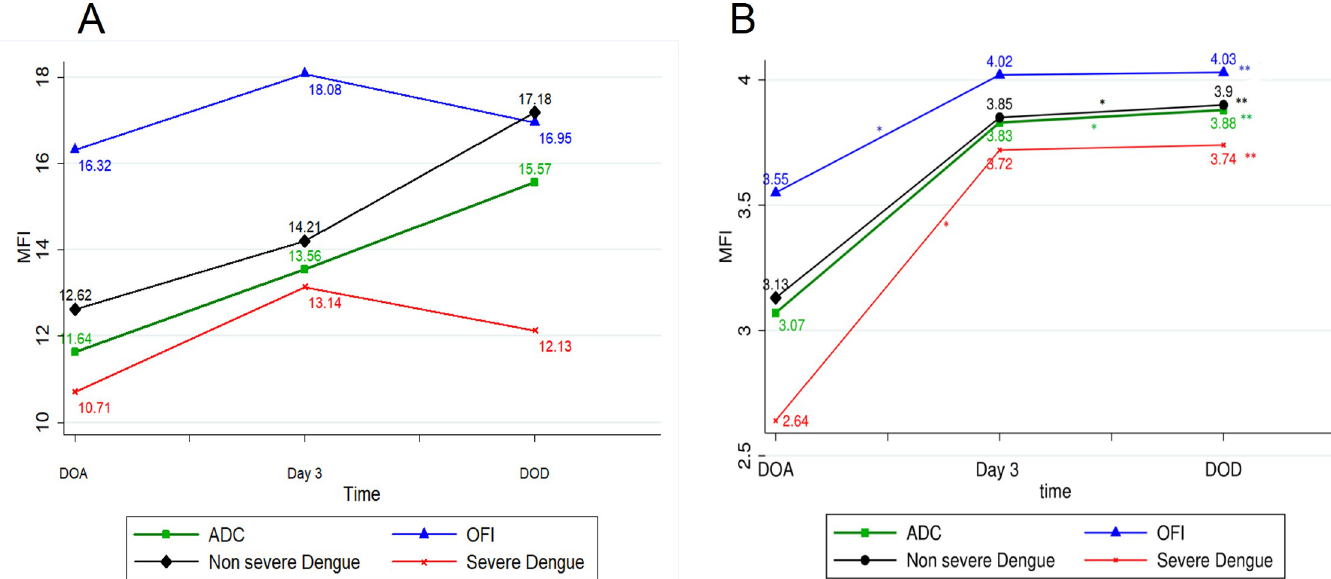
Fig 2. Line graph among different groups (A) DC-SIGN (CD209) (B) FC U R2A (CD32). (ADC- All Dengue cases, OFI–Other febrile illness, DOA- Day of Admission, DOD- Day of Discharge) � comparison between two time points, indicates p value < 0.05 �� Comparison across all three time points, indicates p value < 0.05.